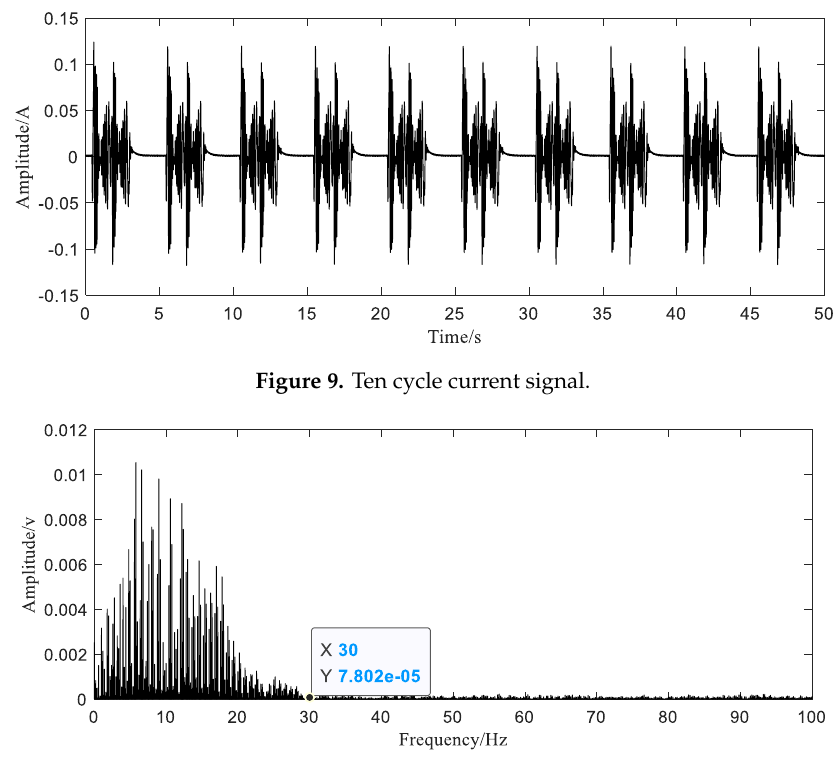
Figure 10. Spectrum of original current signal.